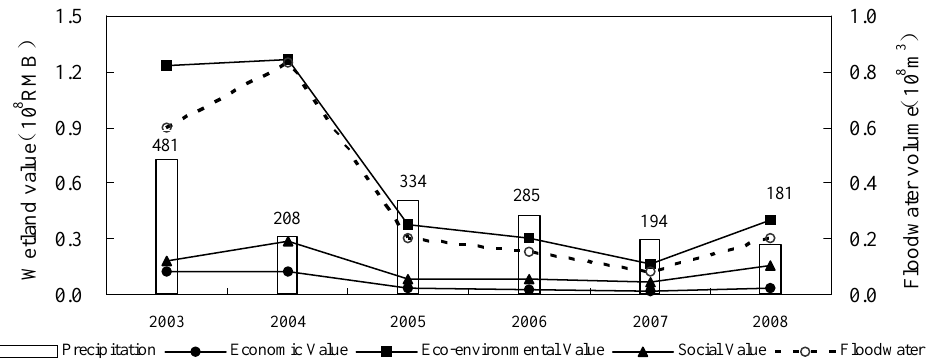
Fig. 3. Relationship between the Xianghai Wetland value and the floodwater volume.